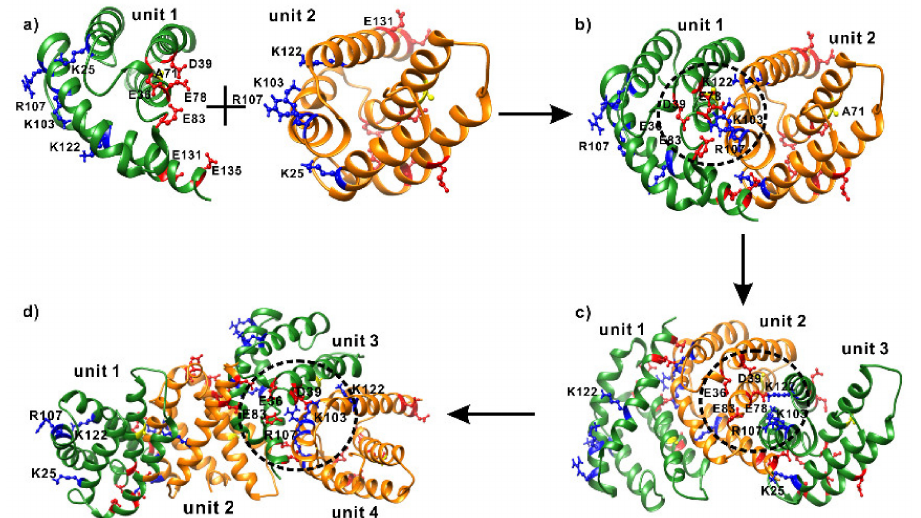
Figure 8. Oligomerization of AcSpN from monomer ( a ) to dimer ( b ), trimer ( c ), and tetramer ( d ). Positively and negatively charged residues located in the interfaces are displayed in blue and red sticks-and-balls, respectively. Inaddition, A71ishighlightedinyellowsticks-and-balls. K122, whichwas selected for mutation but is not in direct intermolecular charge–charge interactions, is also